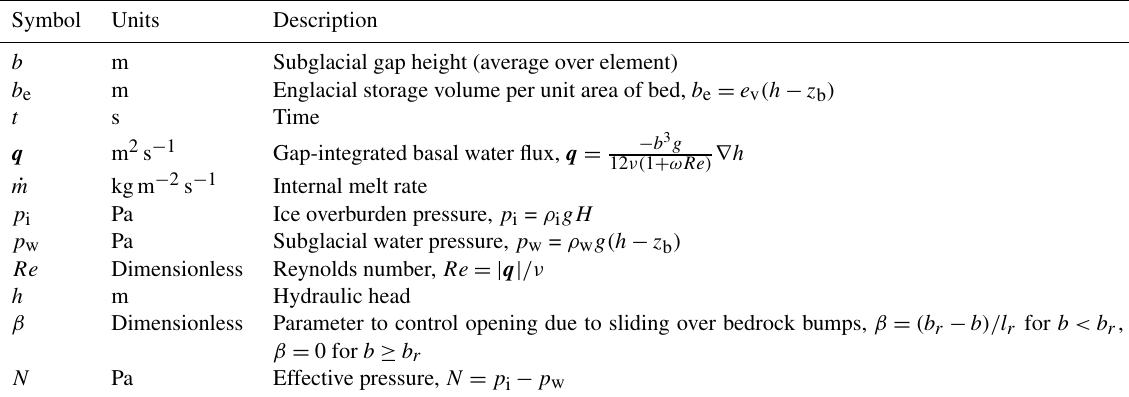
Table 1. Variables used in model equations.